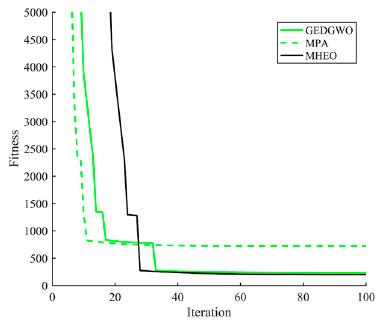
Figure 7. Convergence curves for three algorithms.